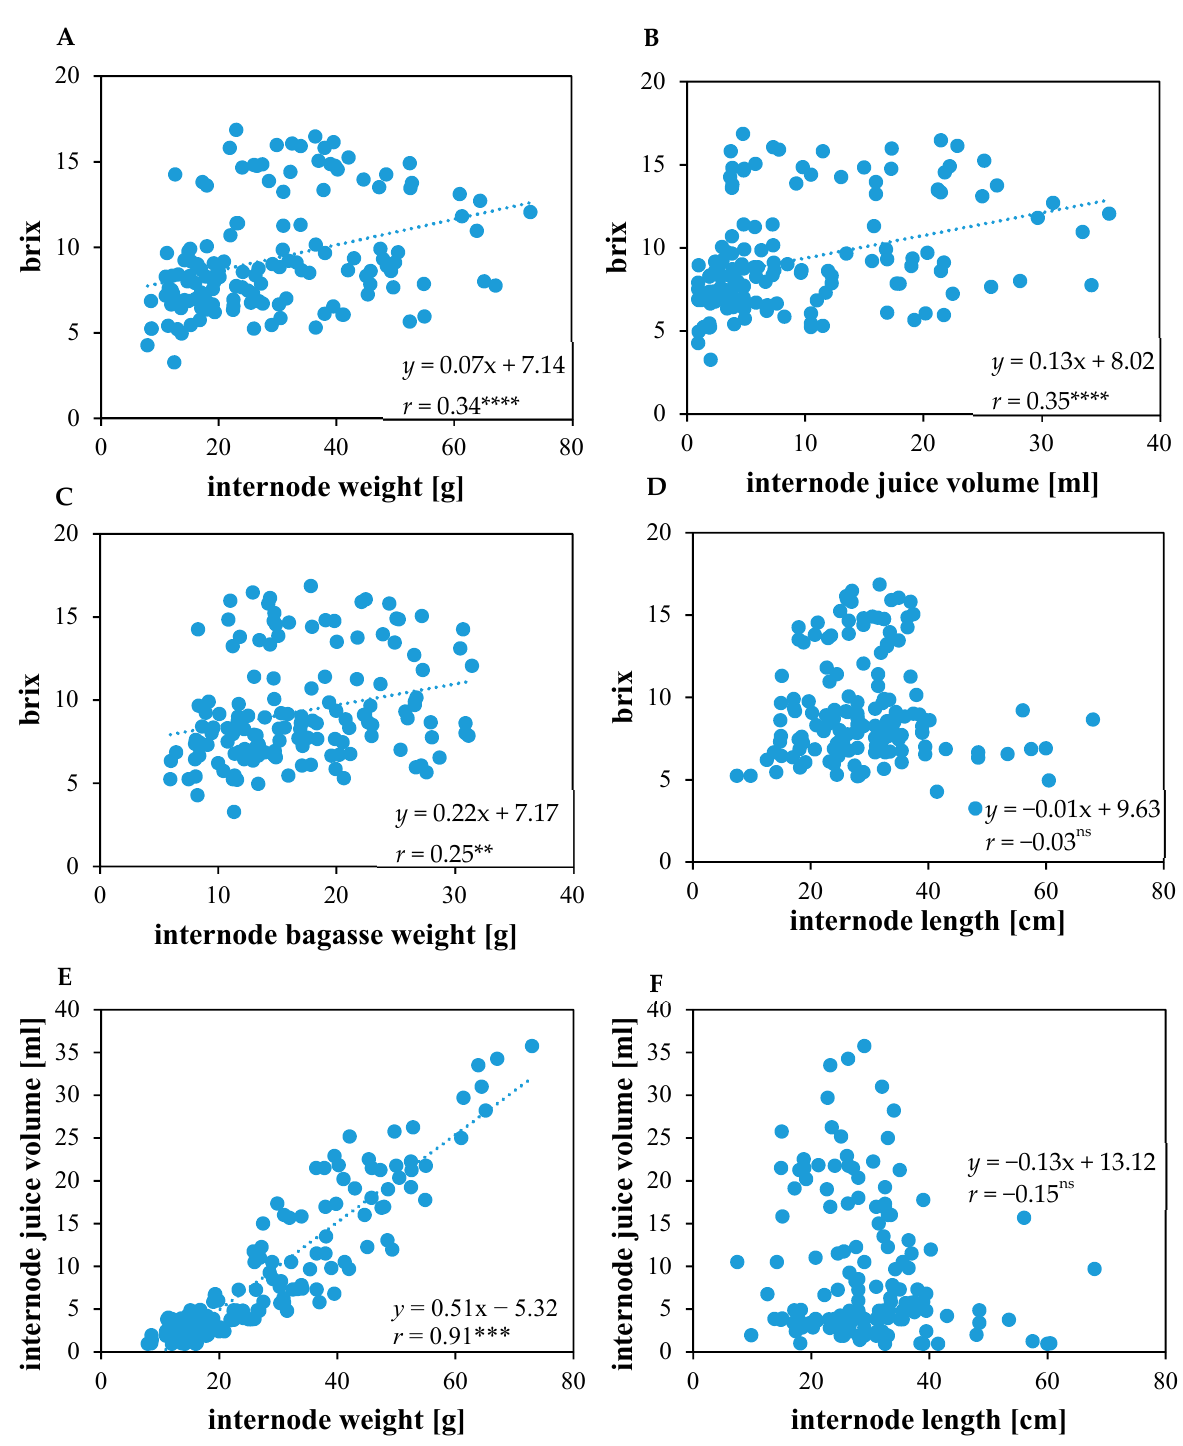
Figure 2. Relationship between sugar-related stem parameters of 14 sorghum genotypes grown in 2018 season in South-West Germany: ( A ) ◦ Brix over weight in individual internodes, ( B ) ◦ Brix over juice volume in individual internodes, ( C ) ◦ Brix over bagasse weight in individual internodes, ( D ) ◦ Brix over length in individual internodes, ( E ) juice volume over weight in individual internodes, and ( F ) juice volume over length in individual internodes. ns = non-significant; *, **, ***, and **** Significant at 0.05, 0.01, 0.001, and 0.0001 probability levels, respectively.